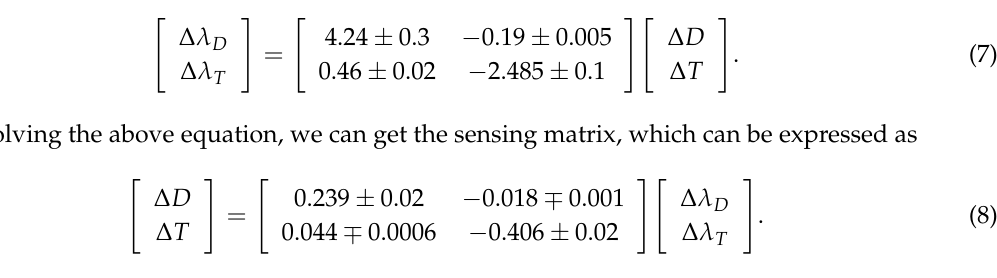
Figure 10. ( a ) The experimental SPR spectrum changing with T ; ( b ) the resonance wavelength shift ∆ λ of DSR (red line) and TSR (blue line) as a function of T